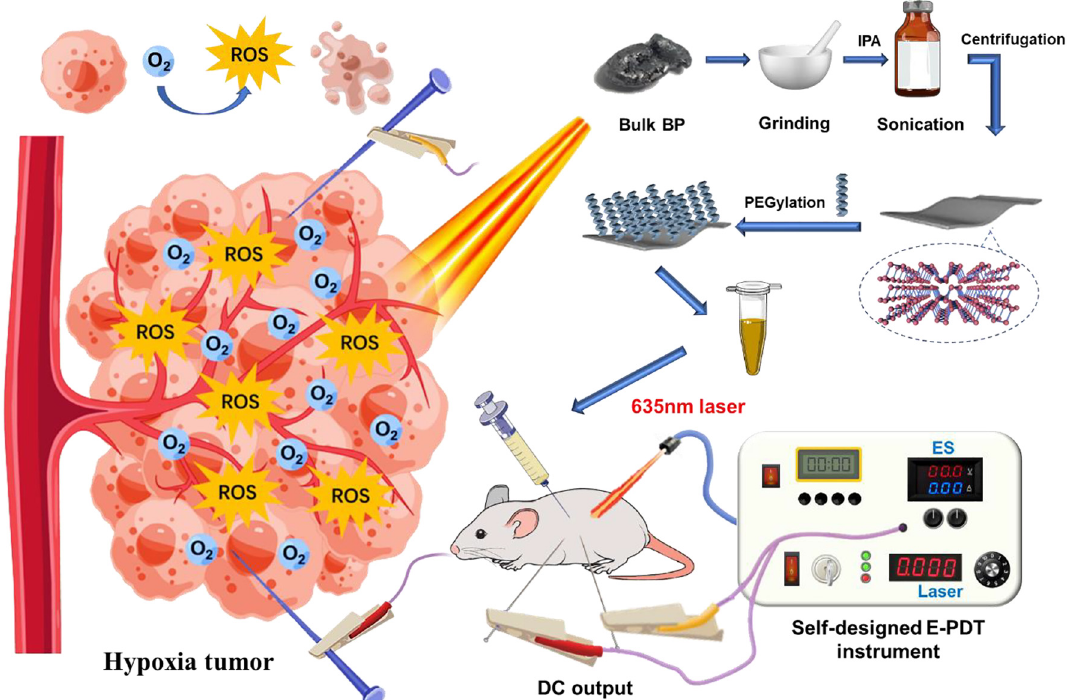
Figure 1: The schematic of sophisticated BPNSs for synergistic antitumor